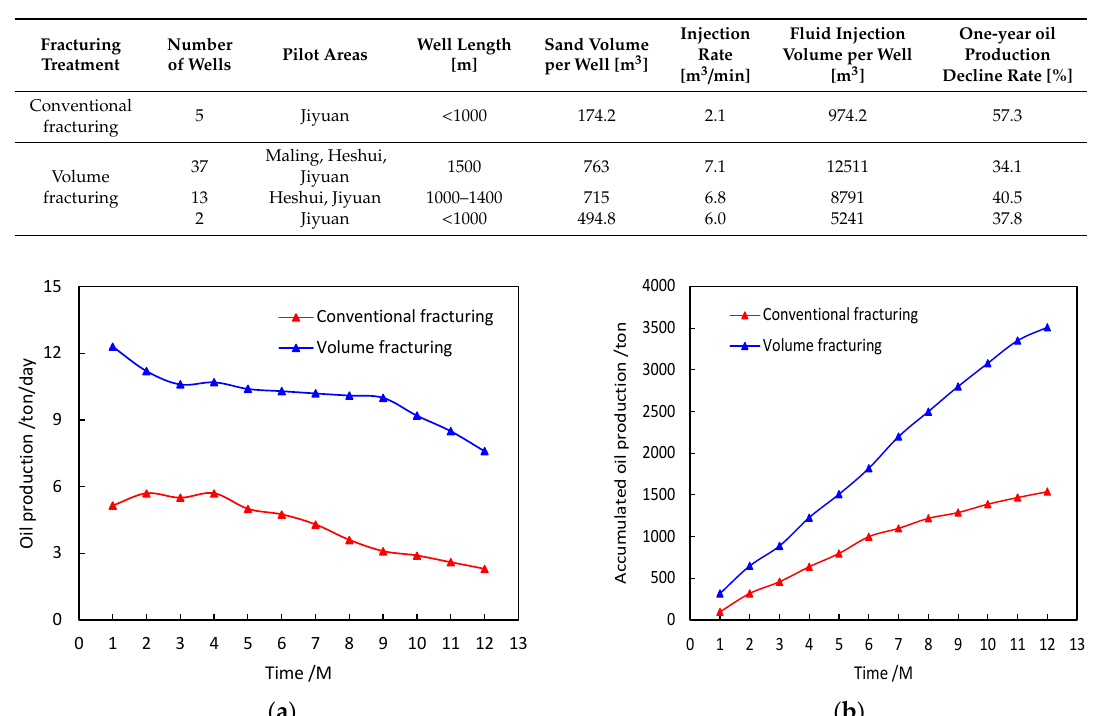
Table 6. Decline of oil production in conventional fracturing and volume fracturing horizontal wells.